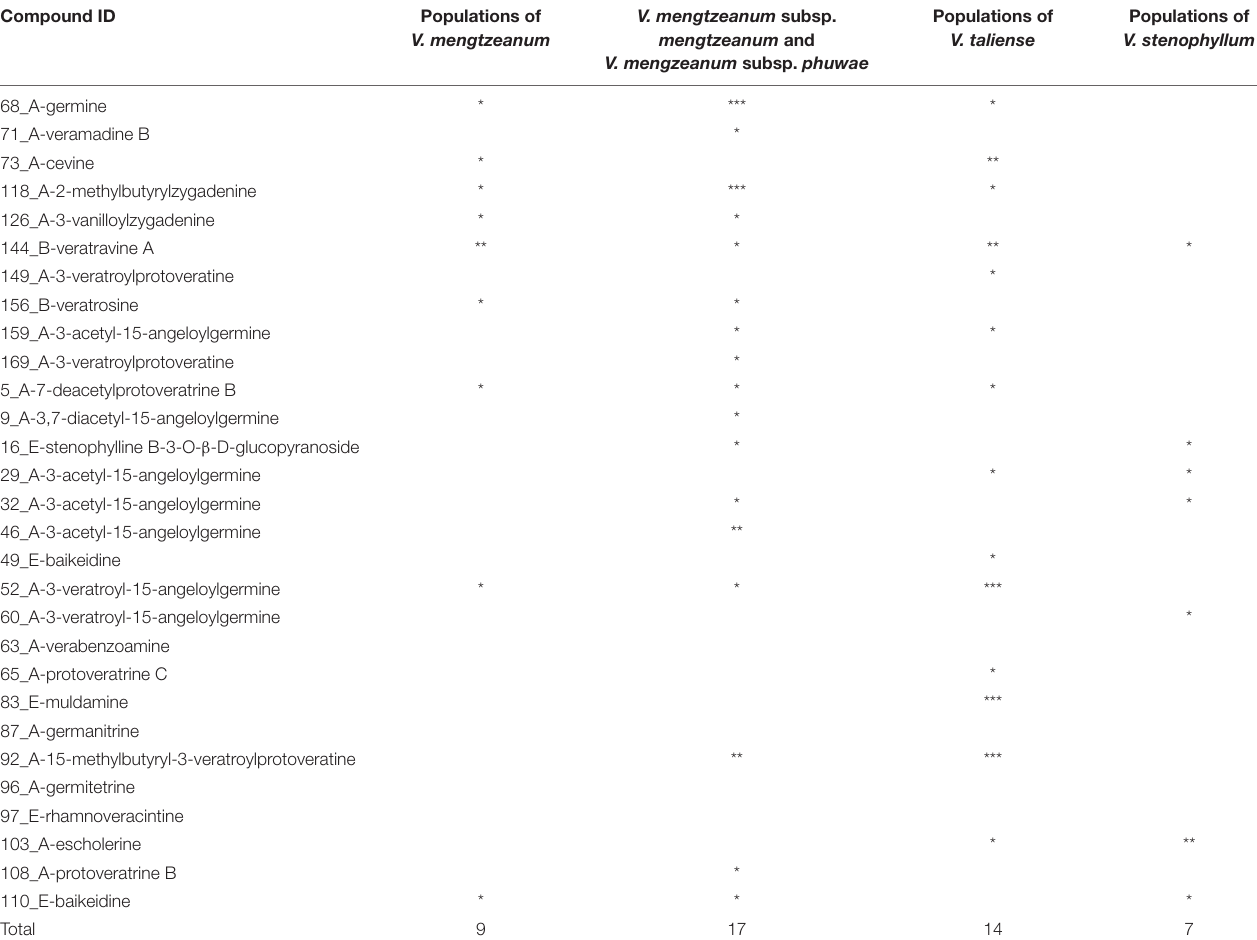
TABLE 4 | Statistical differences in selected variables between populations and